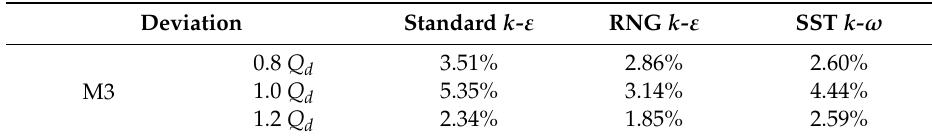
Table 3. Deviation of L p between the turbulence models and the experimental data for the external sound field.